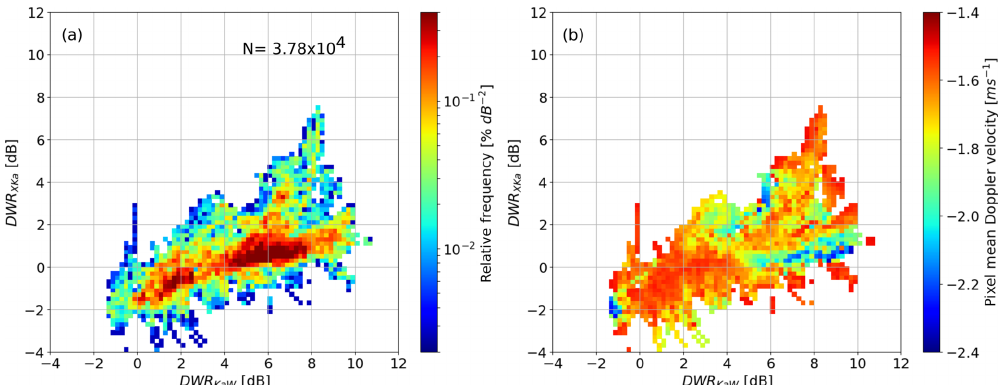
Figure 12. Triple-frequency signatures for Level 2 data with temperatures between − 20 and − 1 ◦ C and a mean Doppler velocity (MDV) above 1.5ms − 1 in order to select potentially rimed particles. Panel (a) shows the relative frequency of the observations. Panel (b) indicates the average MDV of each pixel in the histogram. Note the log scale on the color bar in (a) .